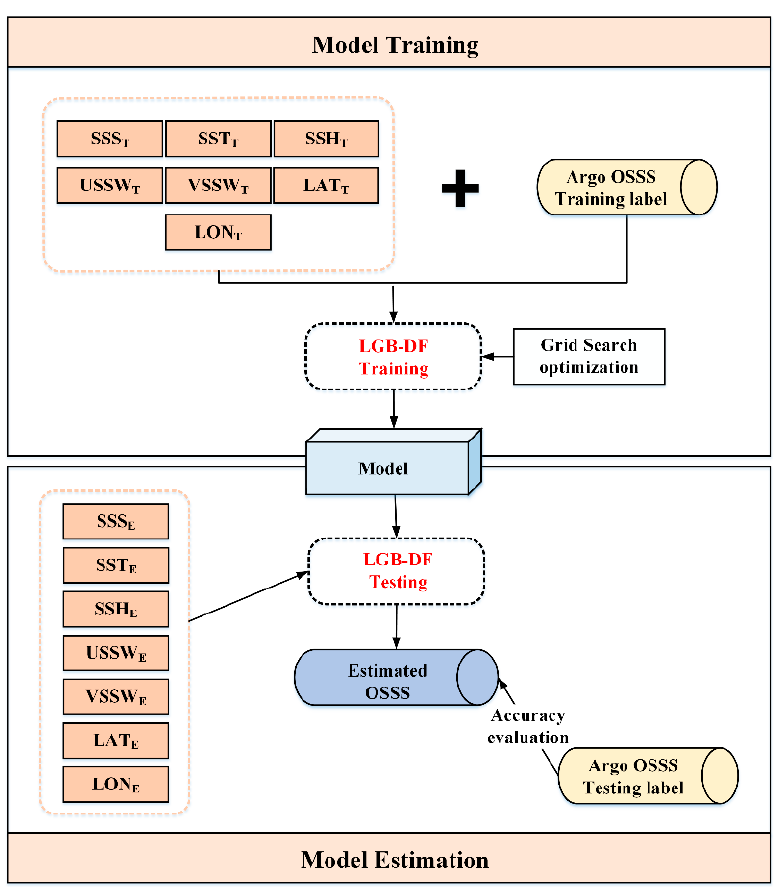
Figure 3. The flowchart of the OSSS estimation in the SCS using the LGB-DF